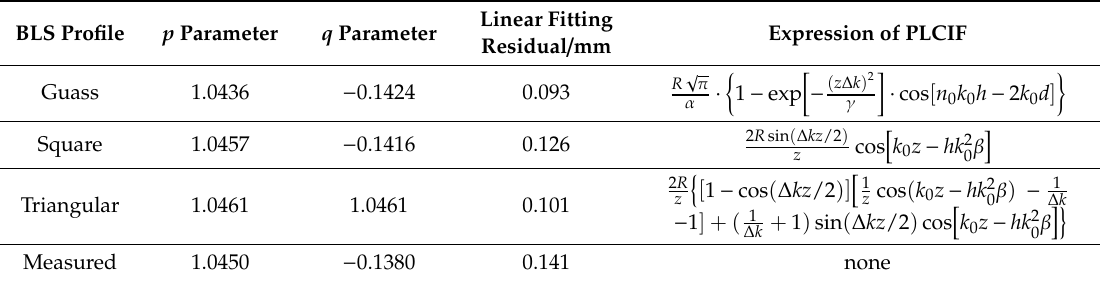
Table 1. The PLCIF with a BLS (broadband light source) in di ff erent profiles and relationship between h m and h c